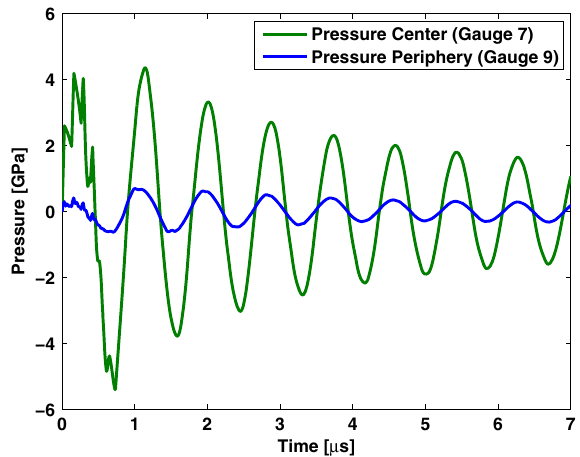
FIG. 8. Pressure response at the center (gauge 7) and periphery (gauge 9) of the target core after a 430 ns proton pulse impact.